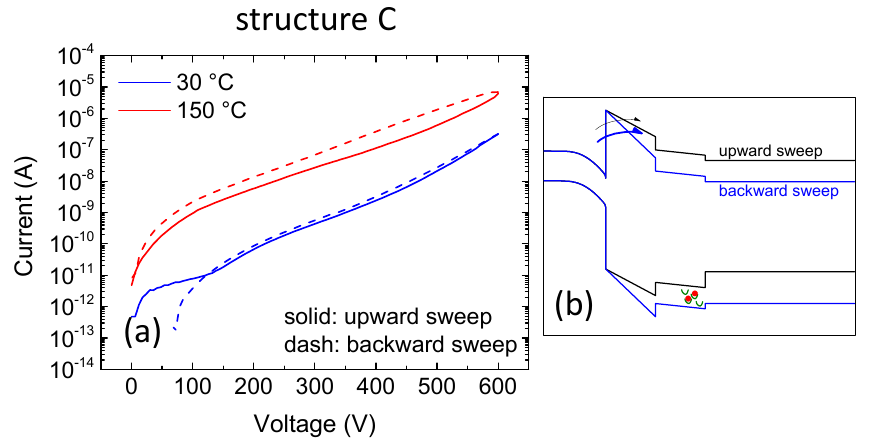
Figure 8. ( a ) Double sweep (upward: solid, backward: dashed) current-voltage characterization on structure C at both room and high temperature. ( b ) represents a schematic band diagram where the electrostatic e ff ect of the positive trapped charges is highlighted.